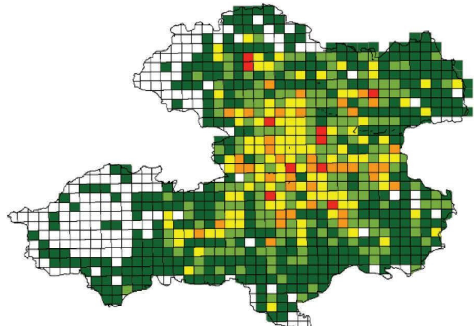
Figure 13: Distribution of